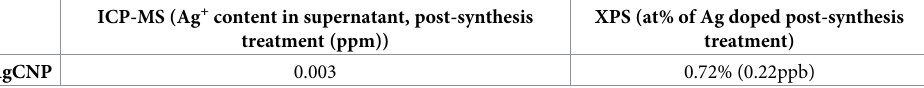
Table 2. ICP-MS and XPS analysis of chemically well-defined nanoparticles post-treatment to remove free silver. Data shows that negligible free silver remains in the solutions, indicating observed effects on mosquitoes are due to incorporated silver and not free silver ion or metal. The at% of silver doped inside nanoceria was markedly lower than the level predicated (only 0.72at% silver was incorporated in AgCNP when the predicted amount was 20%). XPS (at% of Ag doped post-synthesis ICP-MS (Ag + content in supernatant, post-synthesis treatment (ppm))